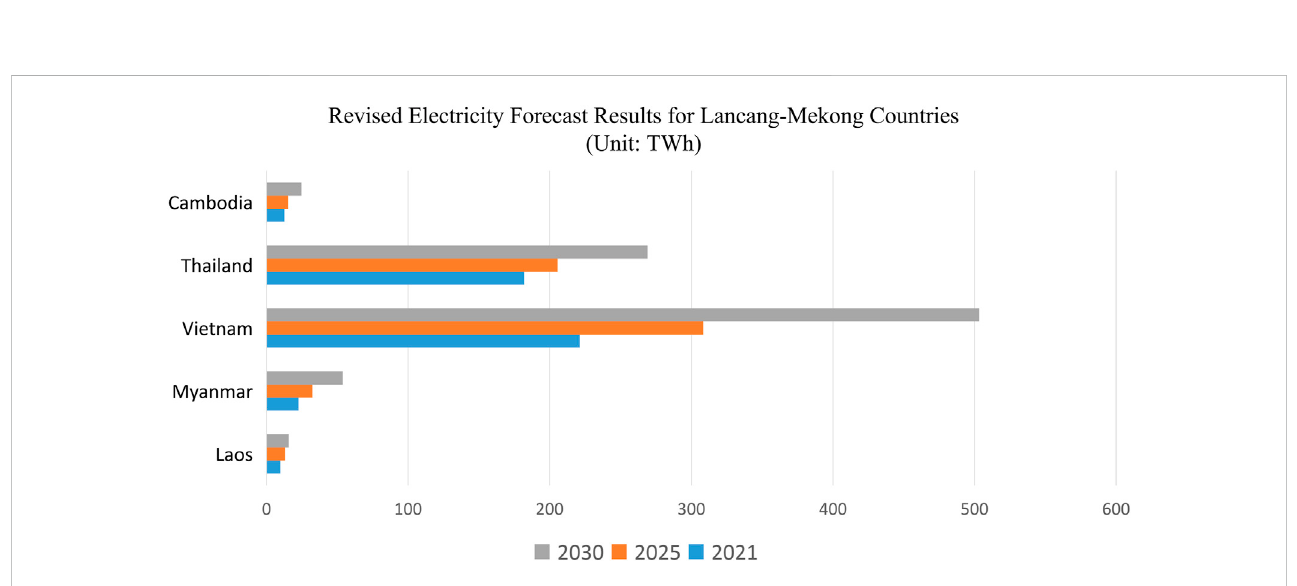
FIGURE 4 Revised electricity forecast results for Lancang- Mekong countries.